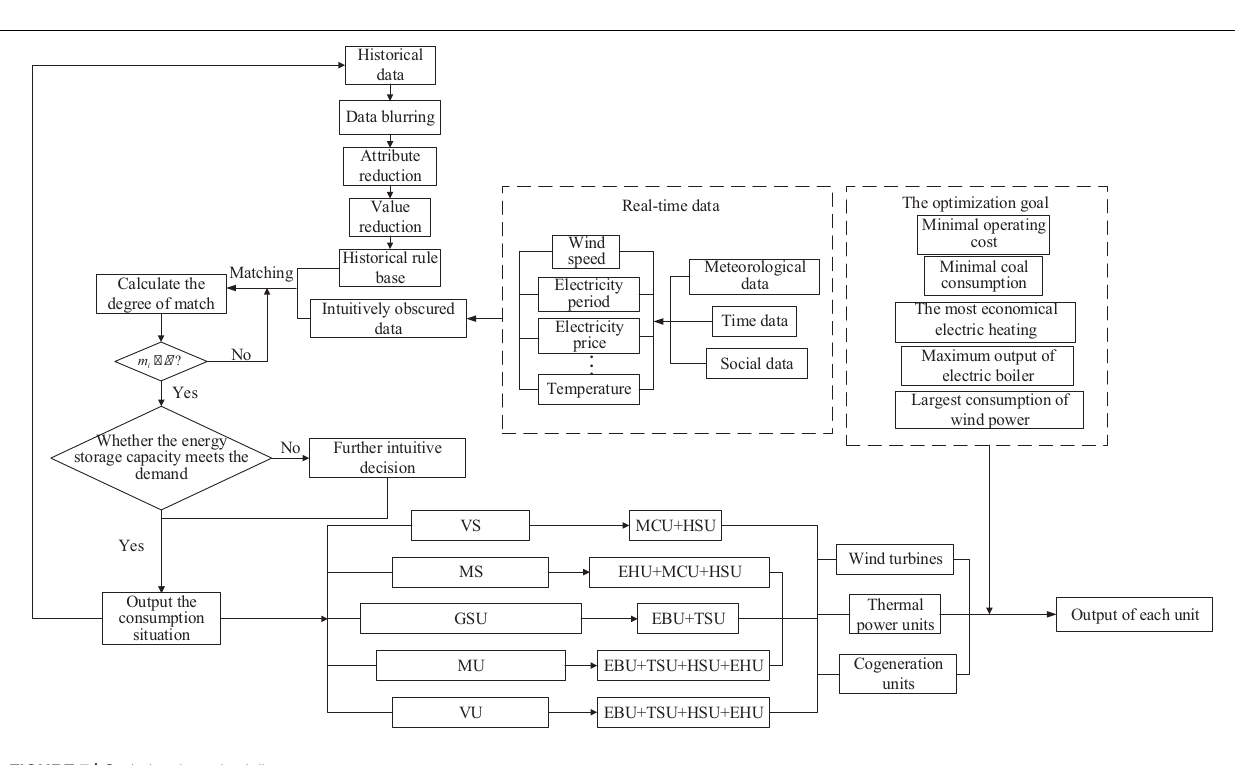
FIGURE 7 | Optimize the scheduling